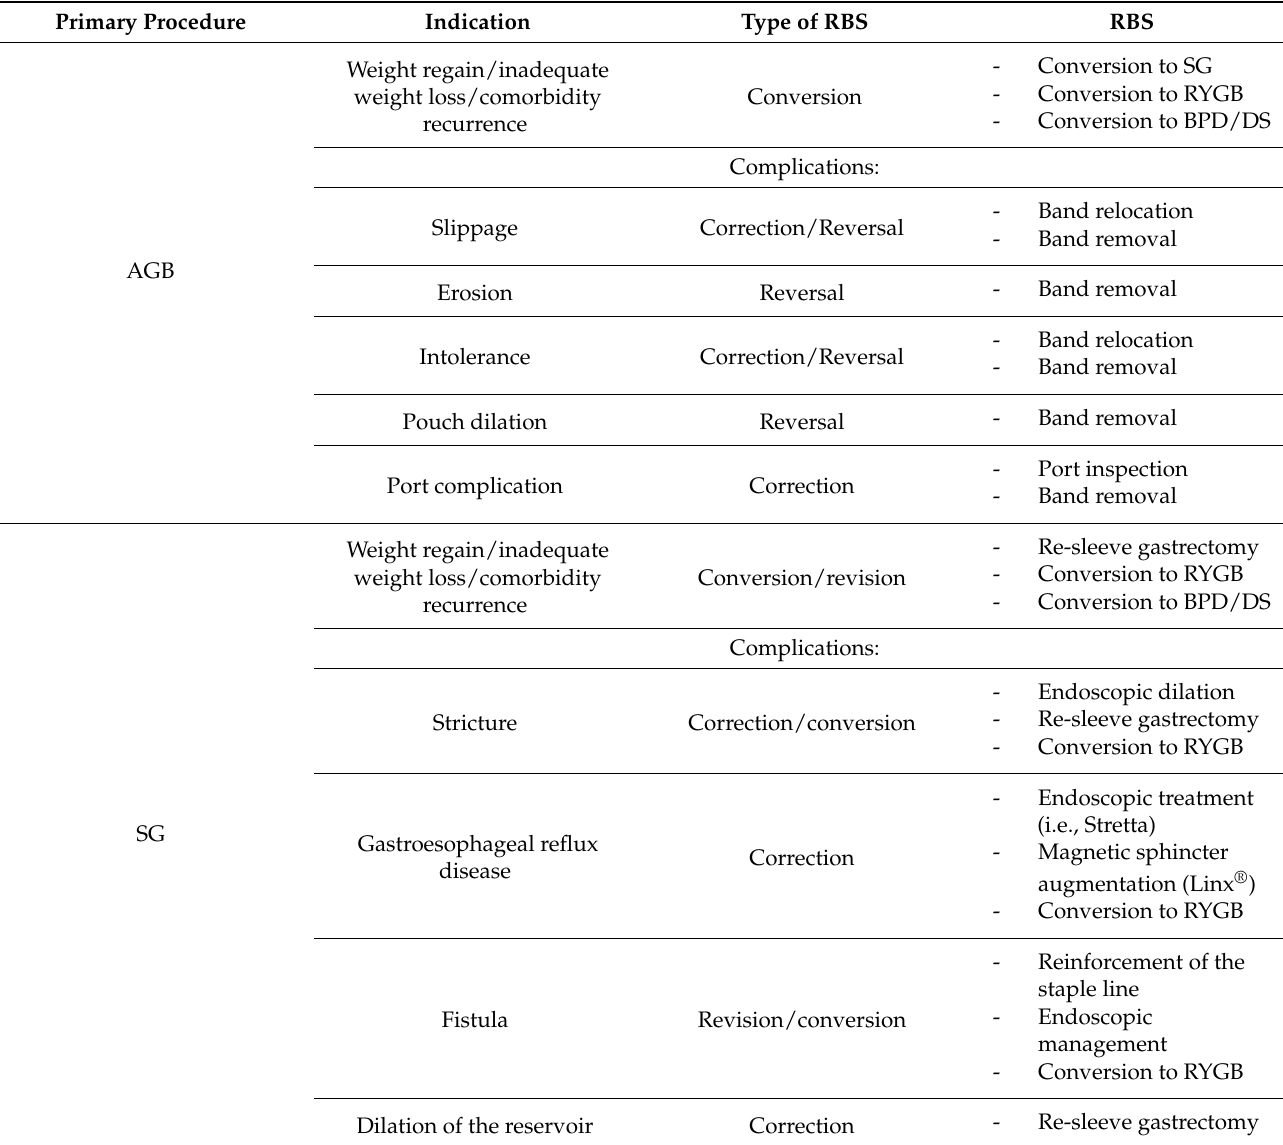
Table 1. Indications, types, and procedures of RBS according to the most common primary bariatric